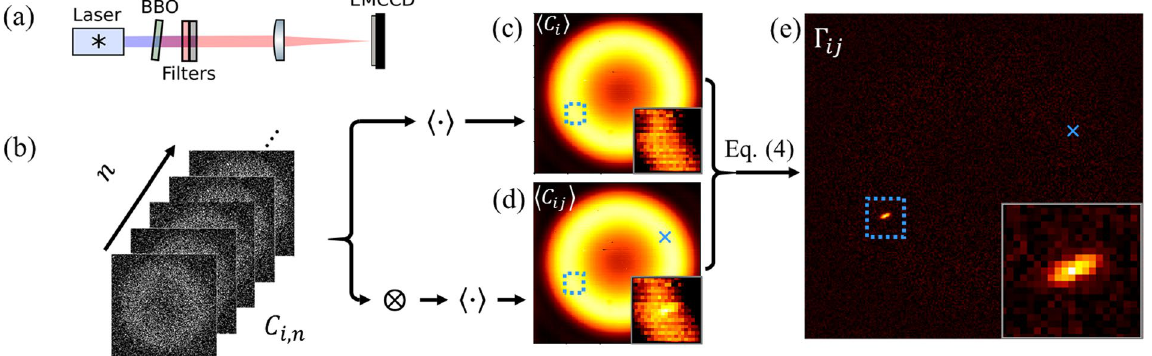
Figure 1. Measuring the biphoton joint probability distribution with an EMCCD camera. ( a ) Experimental setup for measuring far-field type-I SPDC. ( b – e ) Flow chart of data processing. ( b ) The camera acquires many thresholded frames from which we calculate both ( c ) the average of all frames 〈 C (indicated by 〈 · 〉 ) and ( d ) the i 〉 ( ⊗ , Eq. (2)) (shown here for j average of the tensor product of each frame with itself 〈 C ij 〉 indicated by the blue × ). Most coincidences are accidentals between photons from different pairs, yielding the apparent similarity between ( c ) and ( d ). Genuine coincidences from anticorrelated entangled photons appearing within the boxed region give a difference between the two (see insets). ( e ) The conditional probability distribution, via Eq. (4), shows anti-correlation of paired photons localized about i = [ − 70, − 32].